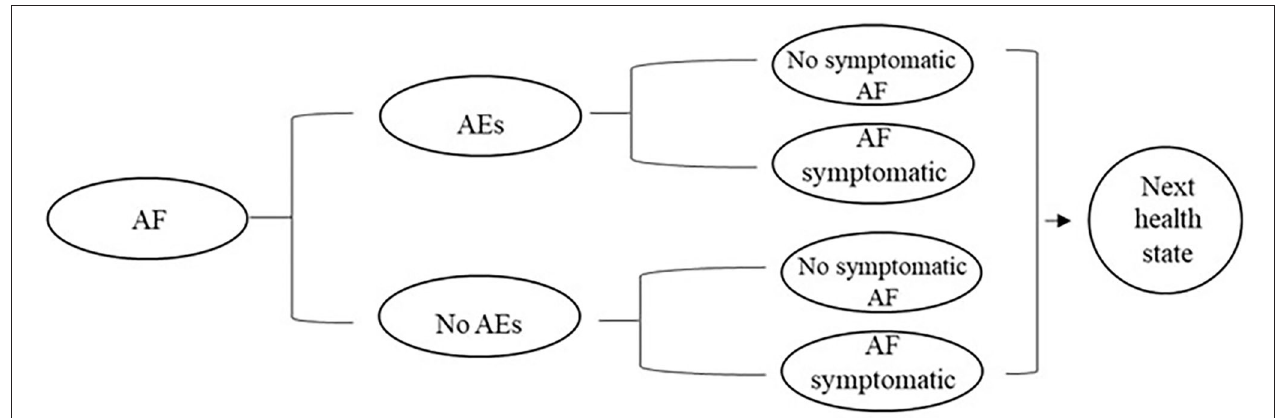
FIGURE 1 | Markov model diagram.